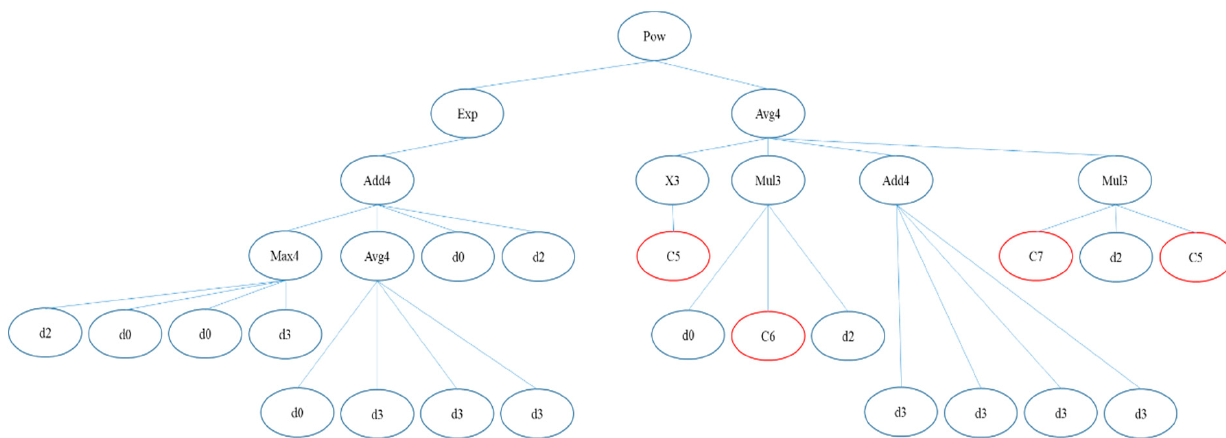
Figure A2. Sub-ET2 of GEP bathymetry retrieval model.